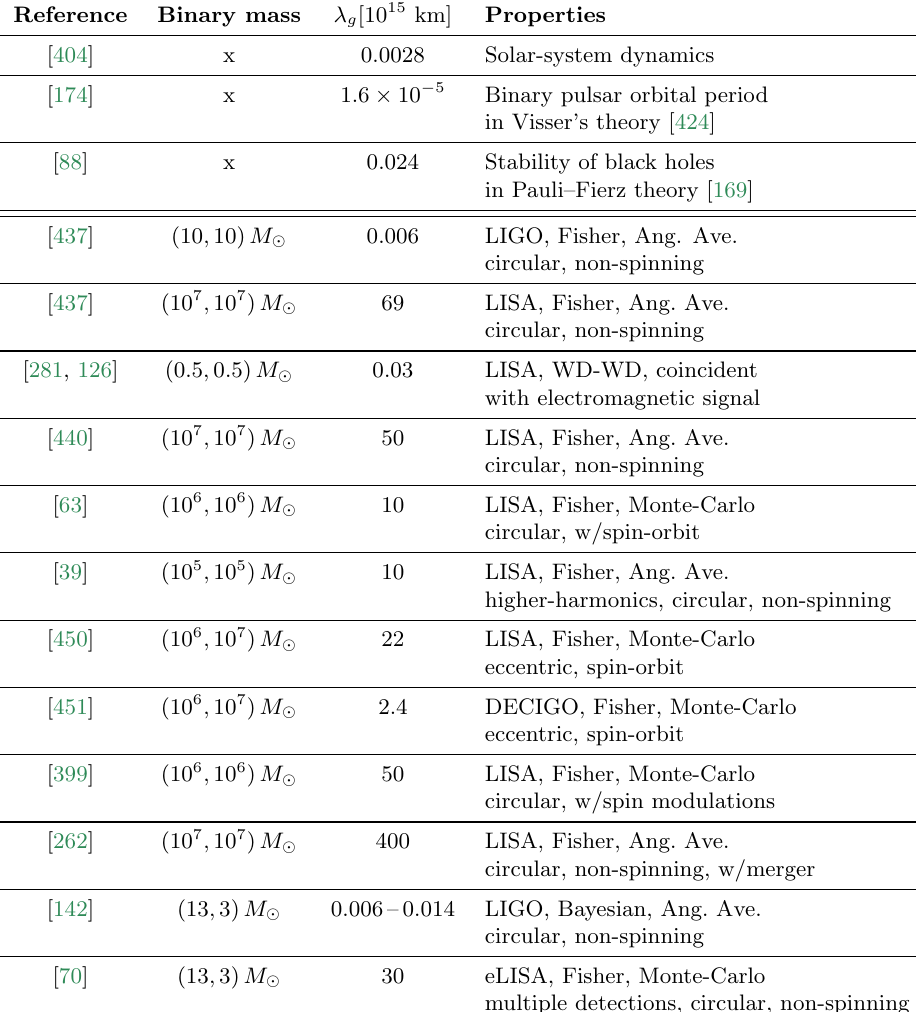
Table 2: Comparison of proposed tests of massive graviton theories. Ang. Ave. stands for an angular average over all sky